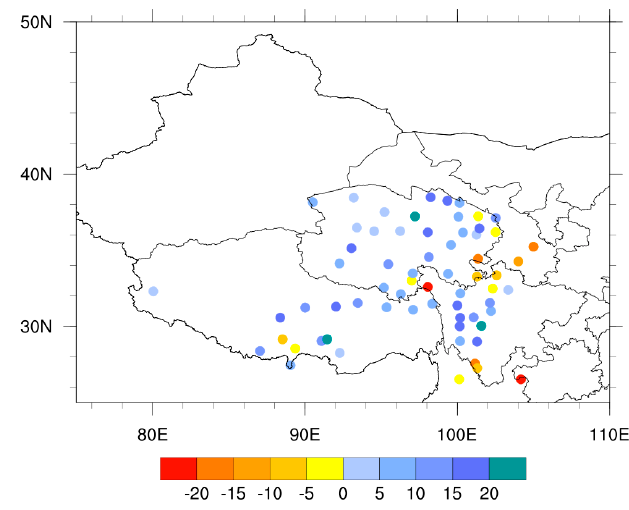
Figure 4. Spatial distribution of long-term trends in the precipitation (mm/10a) during 1961–2015.